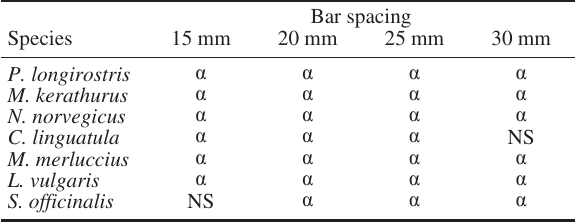
Table 4. – Results of the Kolmogorov-Smirnov test ( α = 0.01; NS not significant) comparing cover and codend length-frequency distributions.